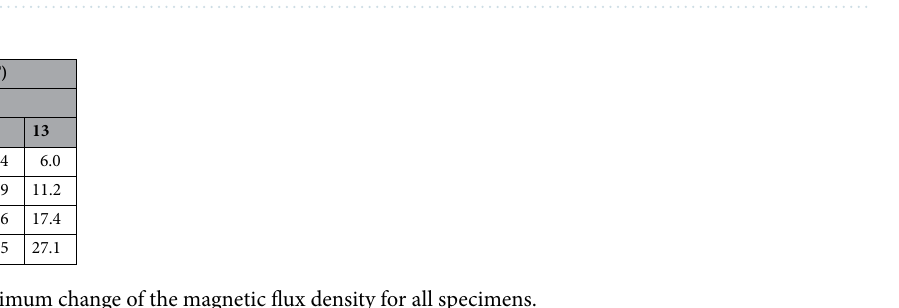
Figure 8. Bending stress and magnetic flux density change versus time for the specimen with 37 Fe–Co fibers.